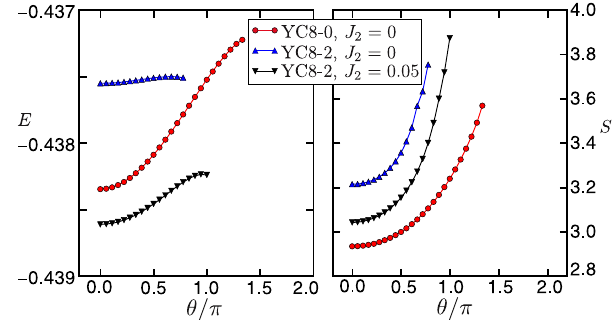
FIG. 9. The energy and entanglement entropy of the KSL under flux insertion. Here, the bond dimension is m ¼ 6000 .